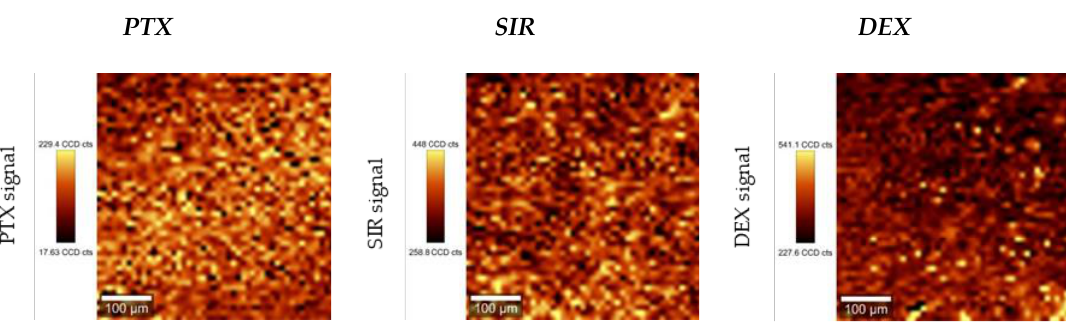
1 Figure 4. Exemplary Raman mapping images for different drugs incorporated in PLLA (PLLA/drug 20/80 w / w %). For CYCLO no distinct Raman signal could be detected.